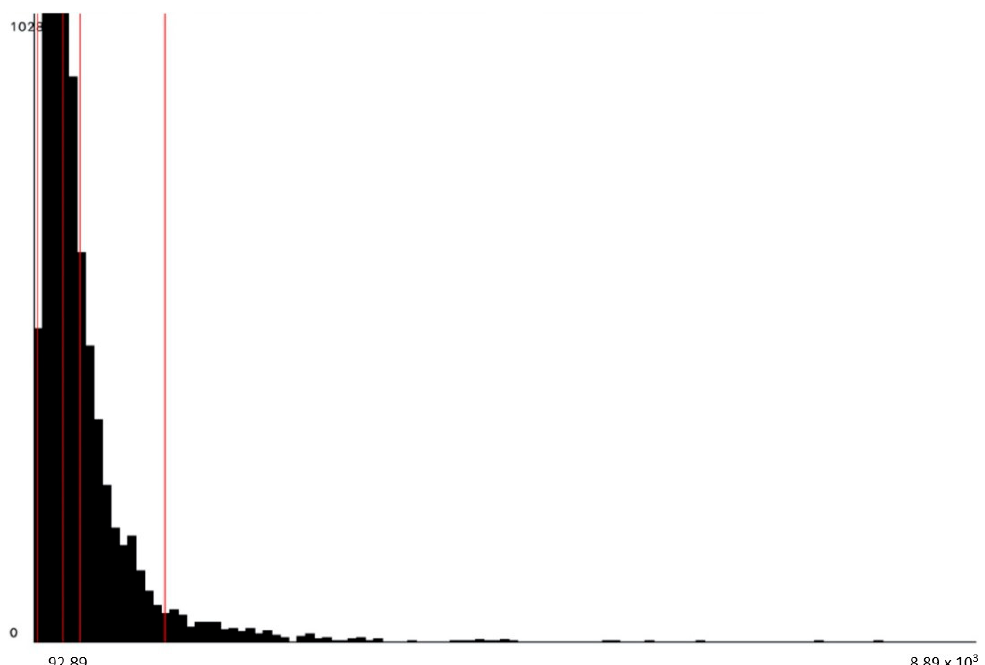
Figure 7. Uncertainty distribution for global warming potential. From left to right, red lines represent the 5th percentile, median value, mean value, and 95th percentile. Table 6. Endpoint results, based on the FU.